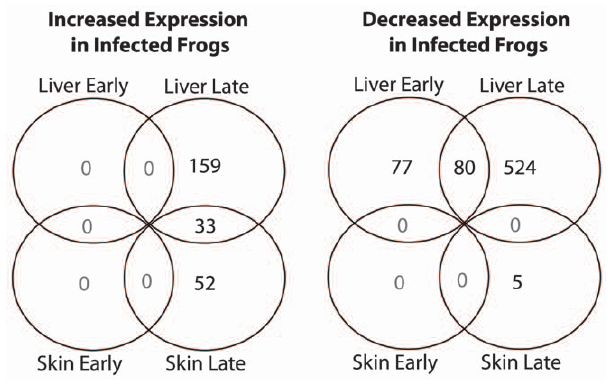
Figure 1. Summary of significant changes in gene expression between Bd -exposed and naı¨ve control frogs. Numbers of genes with increased and decreased expression in infected frogs are shown for the skin (the site of infection) and the liver (an immunologically and physiologically important organ). Data are summarized for two time- points: early (3 days after initial exposure to Bd ) and late (when clinical symptoms of chytridiomycosis are evident).